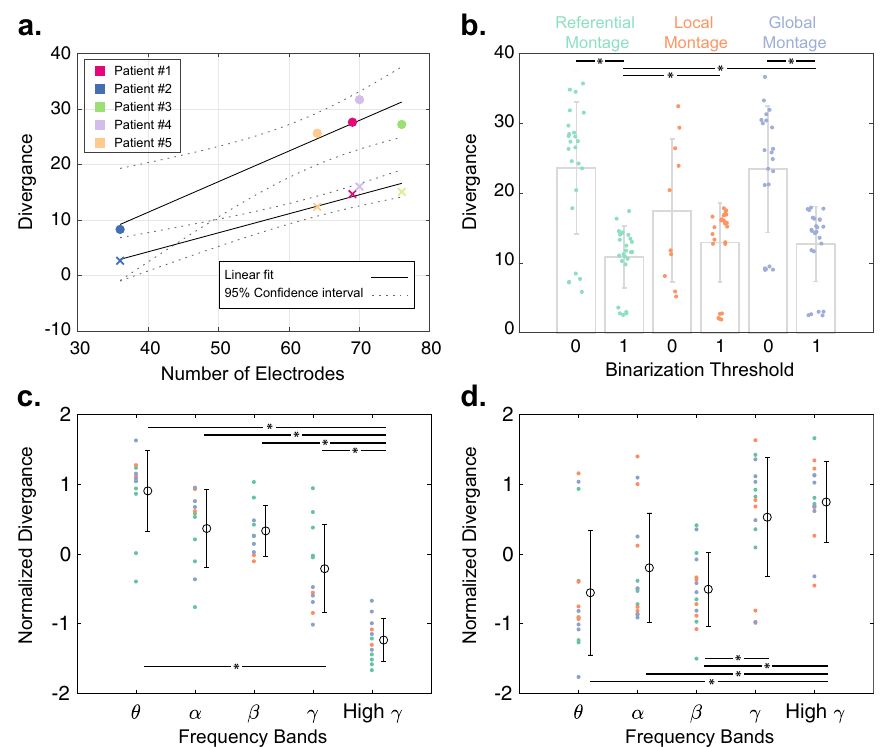
Fig. 8 Goodness-of- fi t of pairwise MEM. We measure the divergence between the empirically observed states ’ empirical and estimated probabilities using a modi fi ed version of Kullback – Leibler divergence (see Materials and Methods section for details). a The relationship between the average (across all frequency bands, and recording montages) divergence of the empirical and estimated probabilities and the number of selected electrodes for each